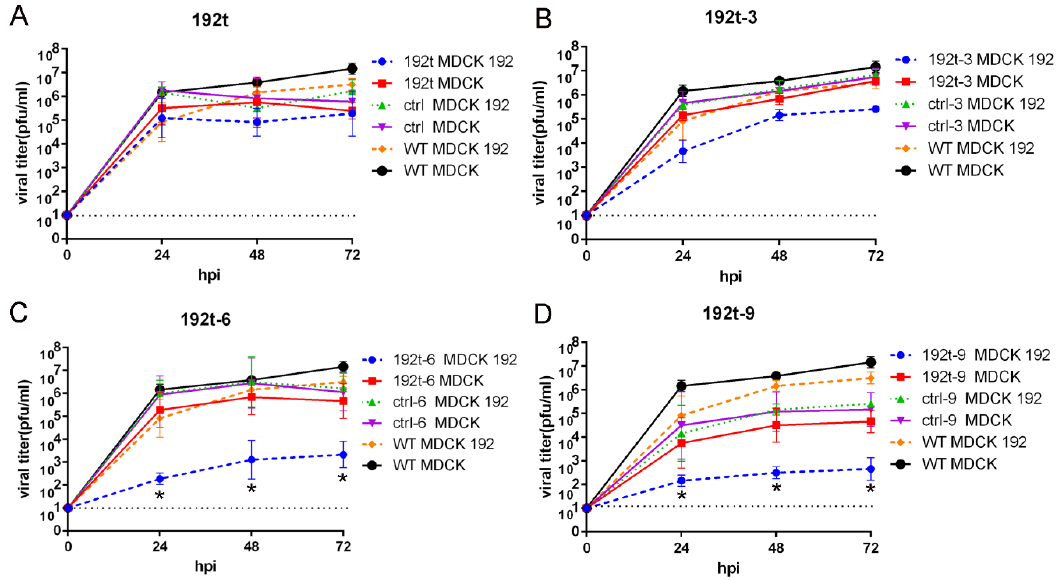
Figure 2. miR-192 targeted viruses of 192t-6 and 192t-9 most effectively reduce viral replications in cells. MDCK and MDCK192 cells were infected with miR-192 targeted viruses and all control viruses at a MOI of 5, ( A ) WT, 192t and ctrl, ( B ) WT, 192t-3 and ctrl-3, ( C ) WT, 192t-6 and ctrl-6, ( D ) WT, 192t-9 and ctrl-9. Virus supernatant was collected at 24 h, 48 h, and 72 h after infection, and quantified by plaque assay. Data points at the indicated times were performed in triplicate; error bars represent standard deviation. * p < 0.05, compared to WT MDCK 192 group. Data are representative of two independent experiments. Dotted line represents limit of detection. Abbreviation: WT, wild type virus; hpi, hours post-infection.